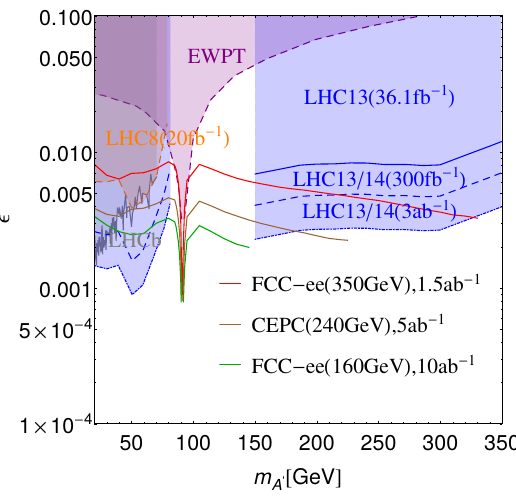
p Figure 5 . Exclusion limits to (cid:15) at di(cid:11)erent colliders. The sensitivities with S= B = 2 at the CEPC with L = 5 ab (cid:0) 1 (brown curve) and at the FCC-ee with L = 10 ab (cid:0) 1 (green curve), 1 : 5 ab (cid:0) 1 (red p curve) for s = 160 GeV, 350 GeV are shown. The 95% C.L. constraints from the EWPTs (purple region), LHC 8 TeV Drell-Yan process with L = 20 fb (cid:0) 1 (orange region), LHC 14 TeV Drell-Yan process with L = 3 ab (cid:0) 1 for 10 GeV < m A 0 < 80 GeV (blue region) are taken from ref. [30] (in fact, QCD K -facotrs should also be included for recasting the results in the Drell-Yan process at the LHC, which will lead to stricter constraints), which is also rescaled to that with L = 300 fb (cid:0) 1 (blue dashed region). The 90% C.L. constraint from the LHCb prompt search is taken from ref.